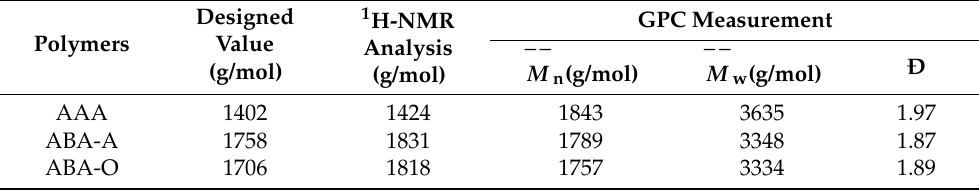
Table 1. Molecular weights of three polymers.